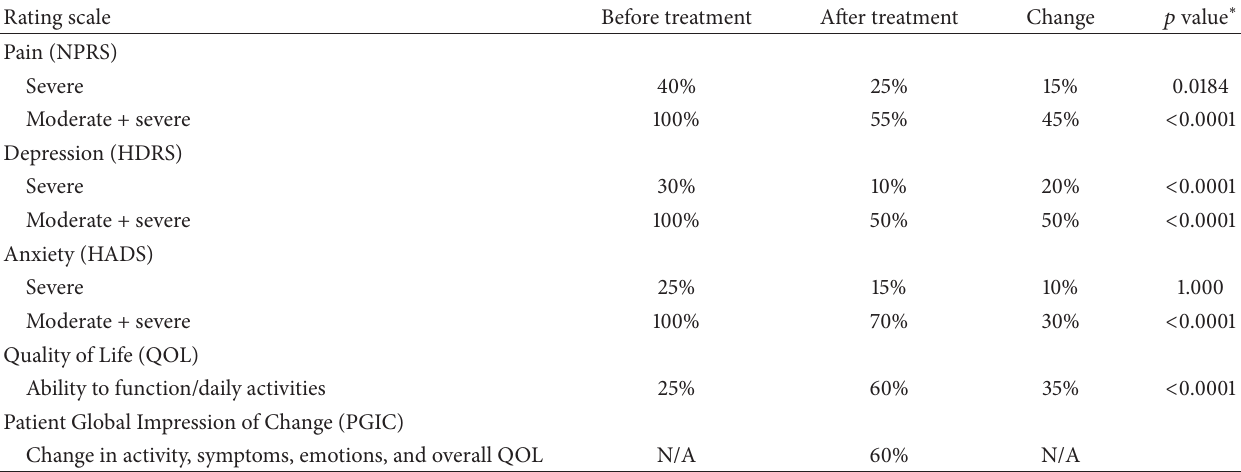
Table 1: Pain, depression, anxiety, quality of life, and Patient Global Impression of Change